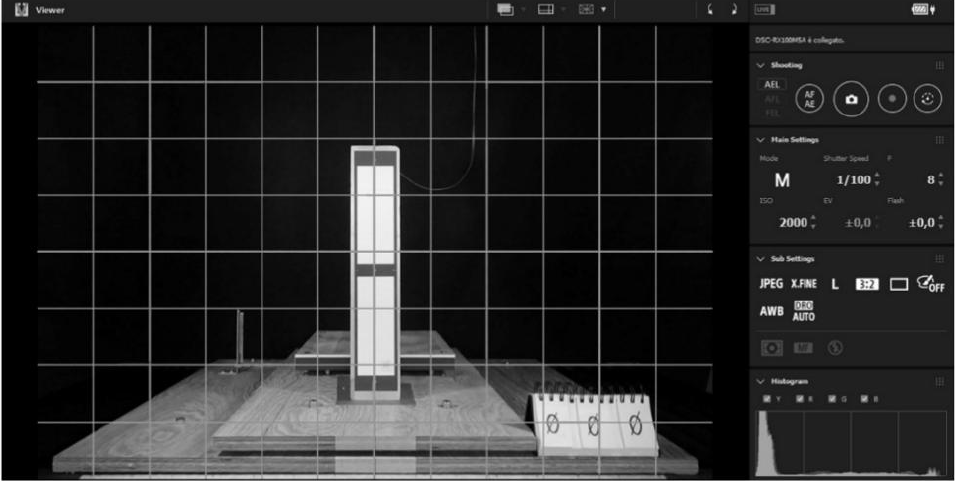
Figure 5. Remote camera control.